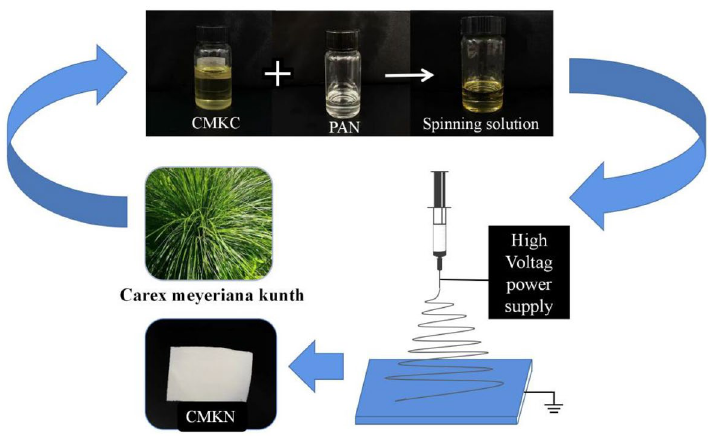
Figure 1. Route of electrospinning